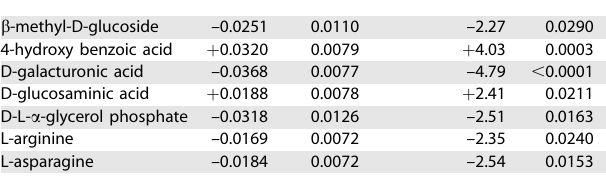
Table 3. Catabolic Activity of Soil Bacteria (as Measured by the Change of the Dye from Colorless to Purple) on the BIOLOG Carbon Sources (Time as Fixed Effect, and Log-Transformed WCD Values as 31 Dependent Variables) Sole-Carbon Sources Estimates Standard Error t -Test p